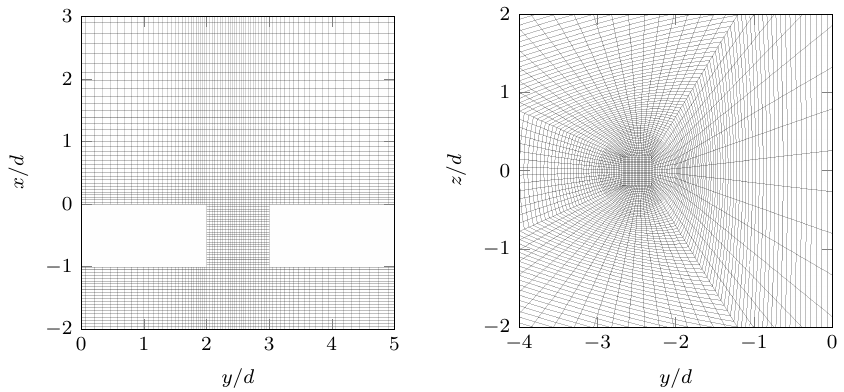
Figure 5. Zoomed view of the computational mesh in the x - y plane ( left ) and y - z plane ( right ). Case s o / d = 5. Only half of the cells are shown for the x-y